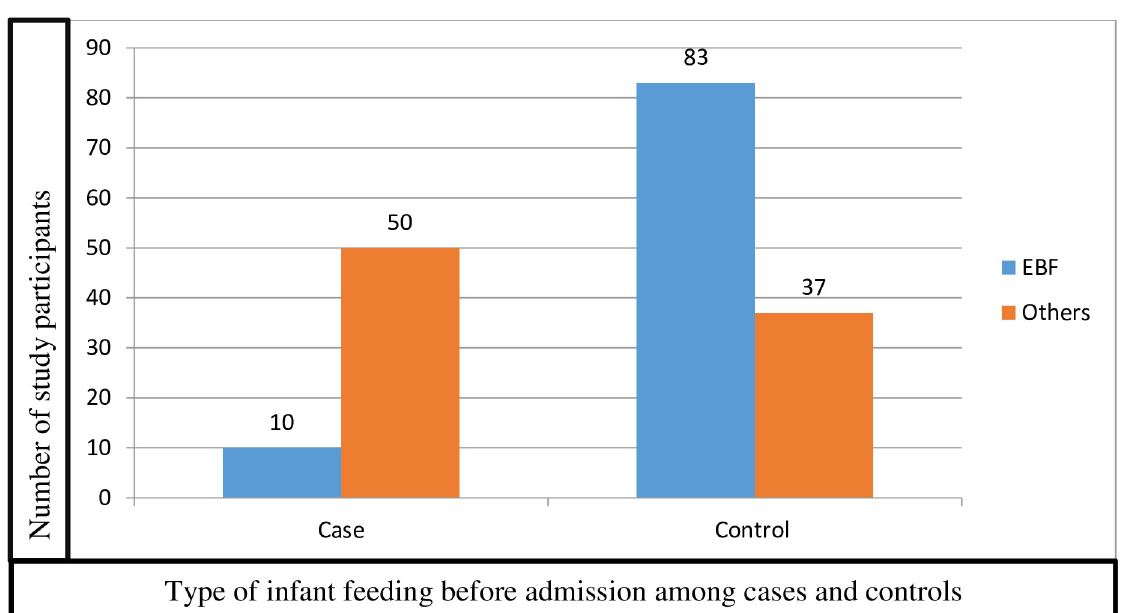
Fig 2. Infant feeding options among neonates admitted to NICU of Arbaminch general hospital, Gamo zone, Ethiopia. Key :— Others = Mixed type and formula